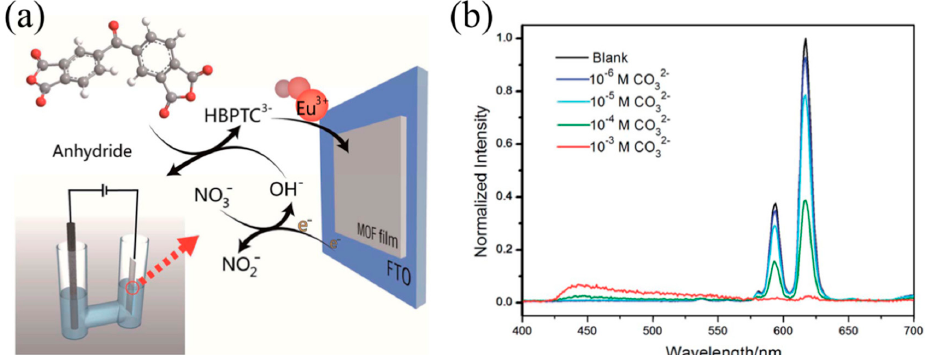
Figure 18. ( a ) General scheme for the cathodically induced electrodeposition of MOFs, involving the reduction in nitrate and generation of HO − , the hydrolysis of anhydride (BTDA) and, MOF crystallization from HBPTC 3 − and Eu 3+ ; ( b ) Emission spectra of the MOF film after being immersed in an aqueous CO 32 − solution at various concentrations (excited at 317 nm). Reprinted with permission from Reference [77]. Copyright 2014 the Royal Society of Chemistry (London,